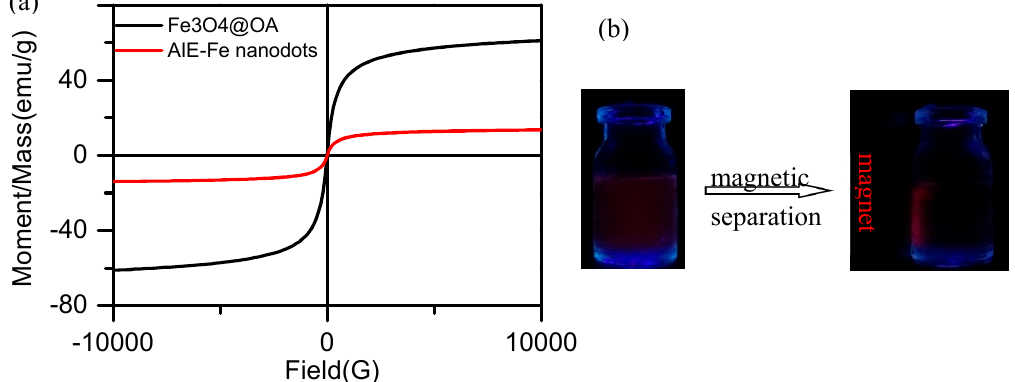
Figure 4. ( a ) Magnetization hysteresis loops of AIE–Fe nanodots and Fe 3 O 4 nanoparticles. ( b ) The photograph of the AIE–Fe nanodots in an external magnetic